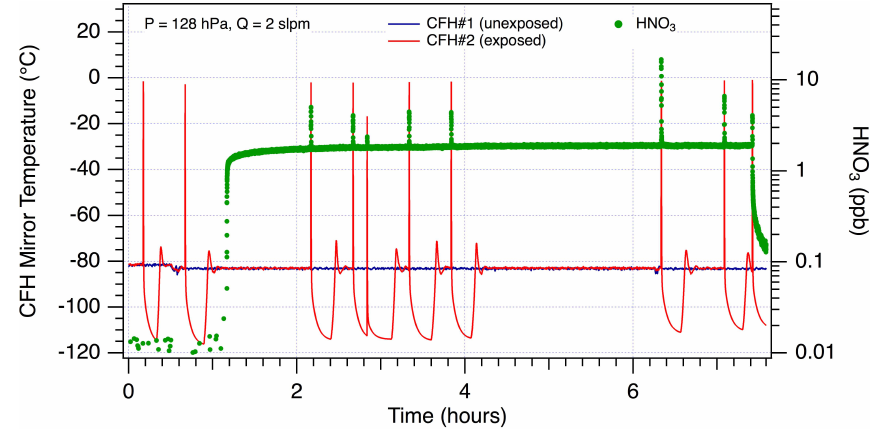
Fig. 4. Time series of CFH mirror temperatures and HNO 3 mixing ratios. The stable mirror temperature corresponds to a water vapour mixing ratio of 2.5ppm. The pulses visible in the CFH#2 mirror temperature are rapid increases used to evaporate the frost layer. Corresponding pulses were observed in HNO 3 as measured by the NO y instrument when the frost layer had been exposed to HNO 3 . The negative excursions in the CFH#2 temperature occur when the frost layer is being reformed following removal.